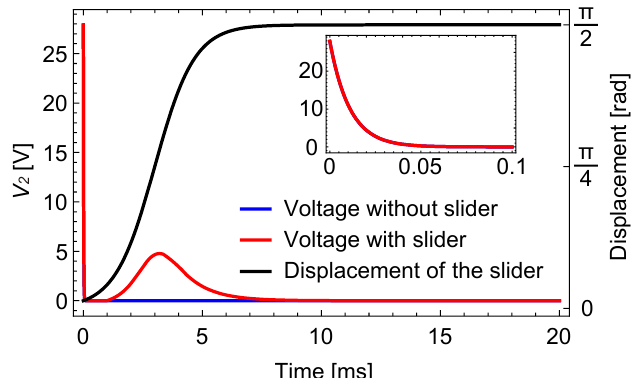
Figure 9. Analytical result for the resistance switching. The resistance R was switched from 100 k Ω to 10 M Ω at 1 ms. The result corresponds to the fourth voltage shift (at 75 ms) in Figure 6. The inset plot magnifies the response at the